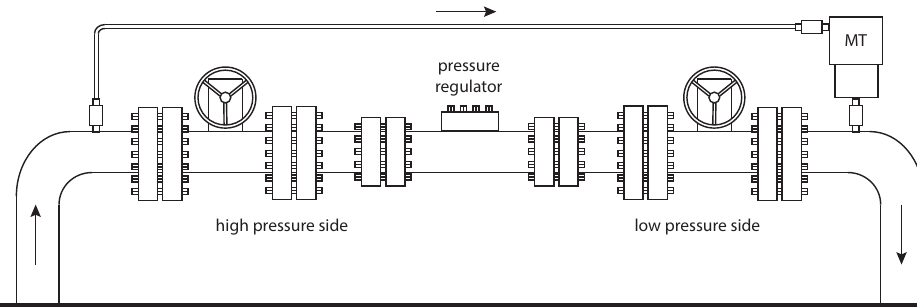
Figure A6. Schematic of a MT installation in parallel with station